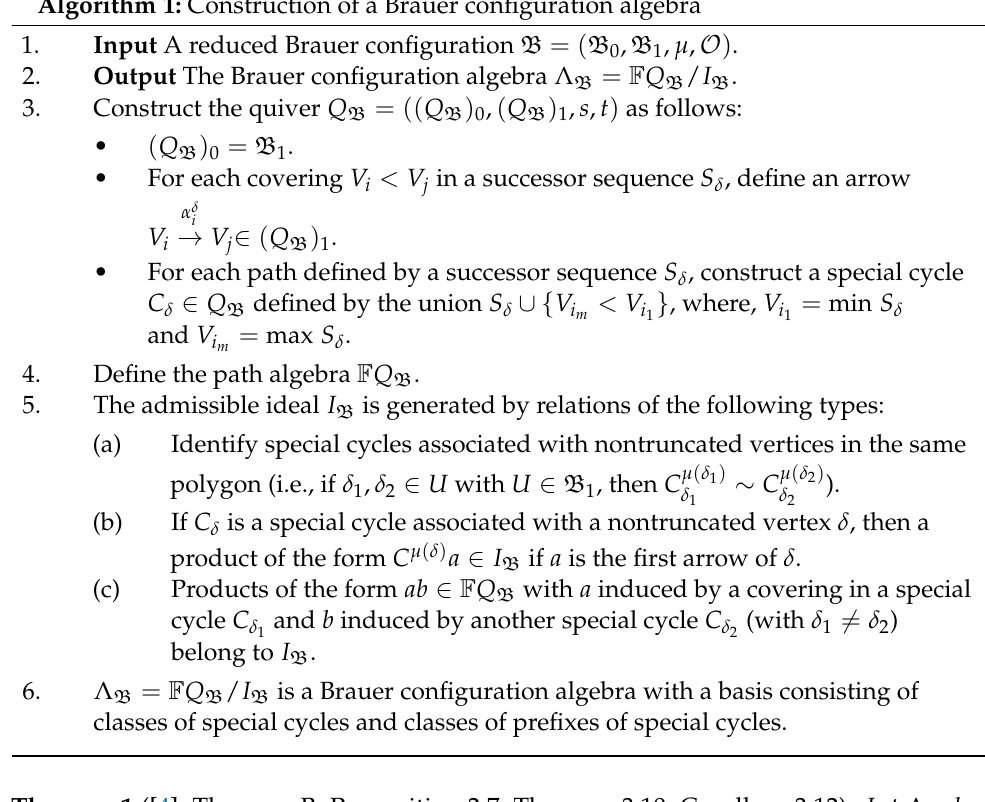
Algorithm 1: Construction of a Brauer configuration